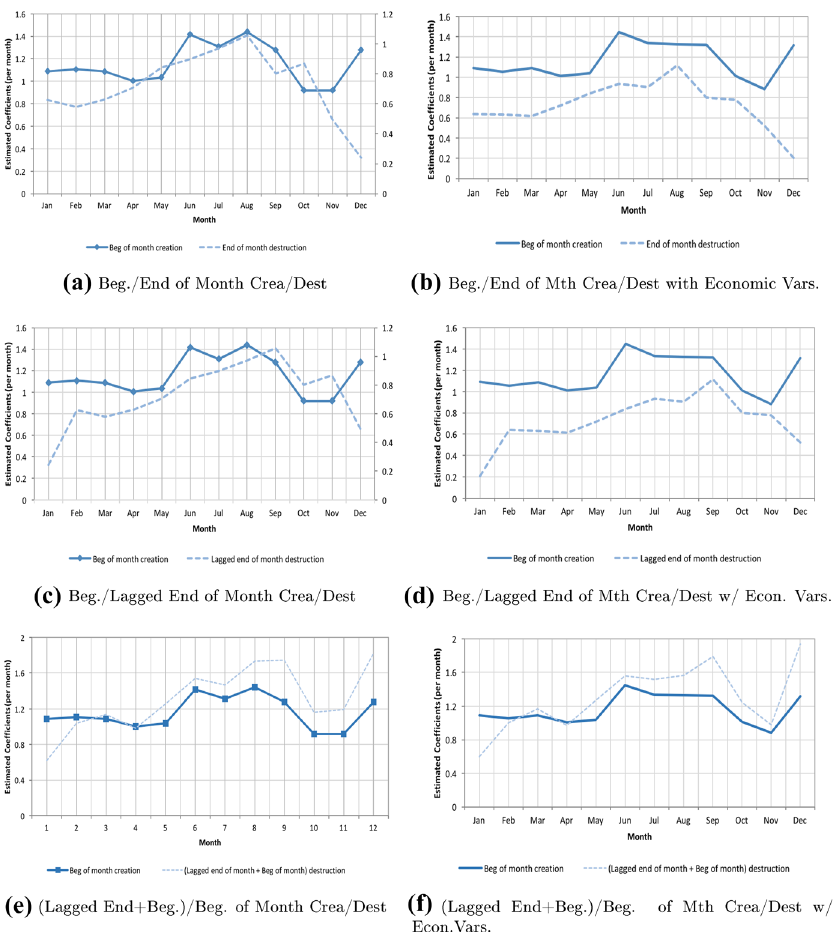
Fig. 4 Estimated Beg/End of month patterns in job creation and destruction